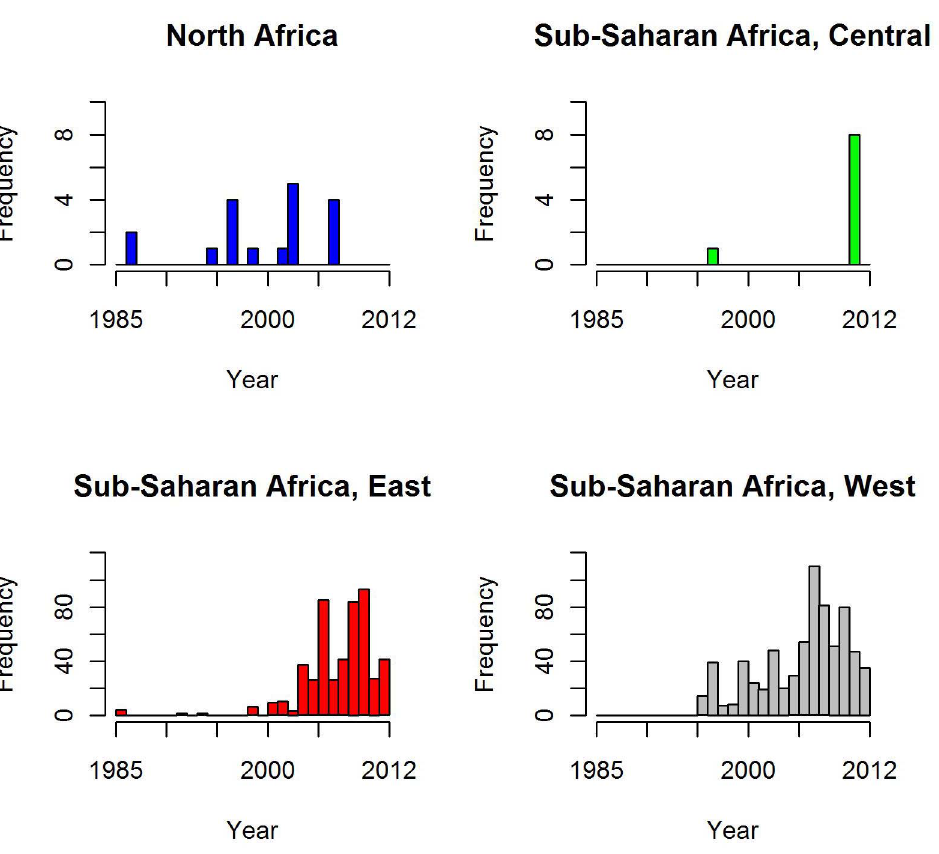
Figure 1. The number of prevalence surveys identified by year and region in Africa, 1985–2012. The graphs show a shift in survey activities from North Africa to other endemic areas, with a recent increase in the number of surveys conducted since 2005 in sub-Saharan Africa.